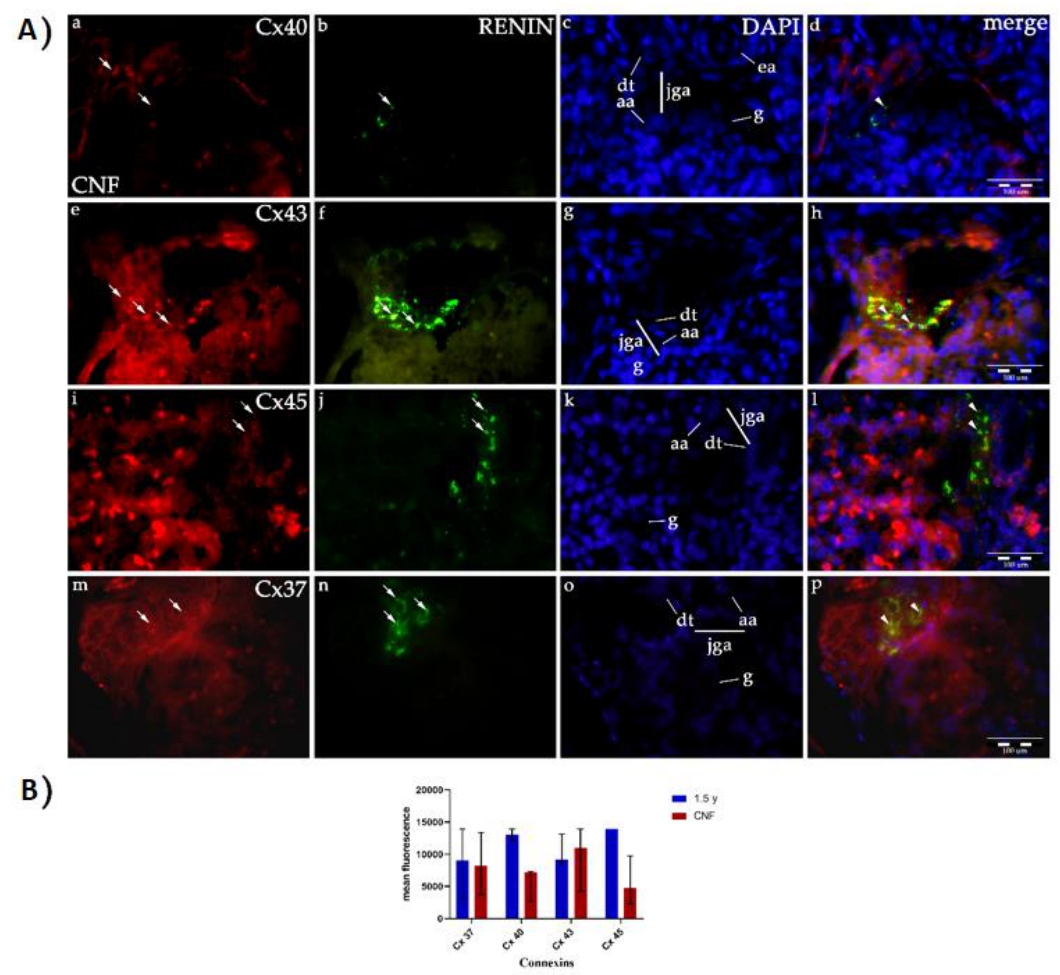
Figure 7. ( A ) Expression of di ff erent Cxs (Cx37, Cx40, Cx43, Cx45) and renin in the JGA region of CNF kidneys: glomeruli (g), a ff erent arteriole (aa), e ff erent arteriole (ea), distal tubule (dt), juxtaglomerular apparatus (jga), expression of Cxs or renin (arrows), co-expression of Cxs and renin (arrowheads). While expression of Cx40 is decreased in jga of CNF kidneys ( a – d ), expression of Cx43 ( e – h ), Cx45 ( i – l ) and Cx37 is increased ( m – p ). Double immunofluorescence staining of DAPI nuclear stain with Cx40 / renin, Cx43 / renin, Cx45 / renin and Cx37 / renin of CNF human kidneys magnification × 100, scale bar 40 µ m. ( B ) Bar plot (median ± interquartile range for technical replicates) showing the di ff erence between the expression of Cx37, Cx40, Cx43 and Cx45 in healthy postnatal and CNF kidneys. In hypertrophic CNF glomeruli, Cx43 is strongly expressed in the a ff erent arteriole and macula densa of JGA. Cx43 and renin are strongly co-expressed in the JGA region, but also in glomeruli and cells corresponding to extraglomerular mesangium (Figure